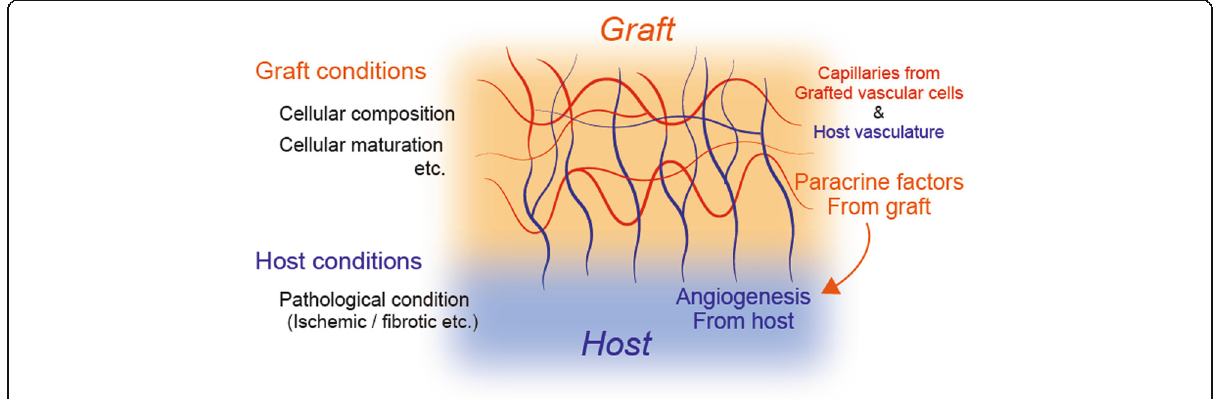
Fig. 3 Schematic summary of the mechanism of capillary formation in 3D cardiac tissue. Biological interaction between host and graft results